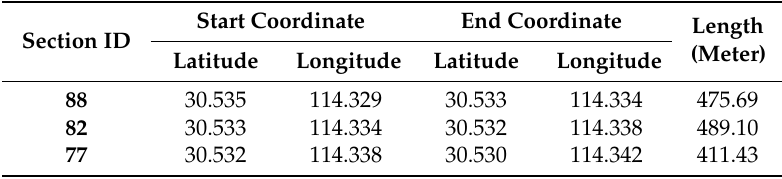
Table 4. Selected arterial road network used in the